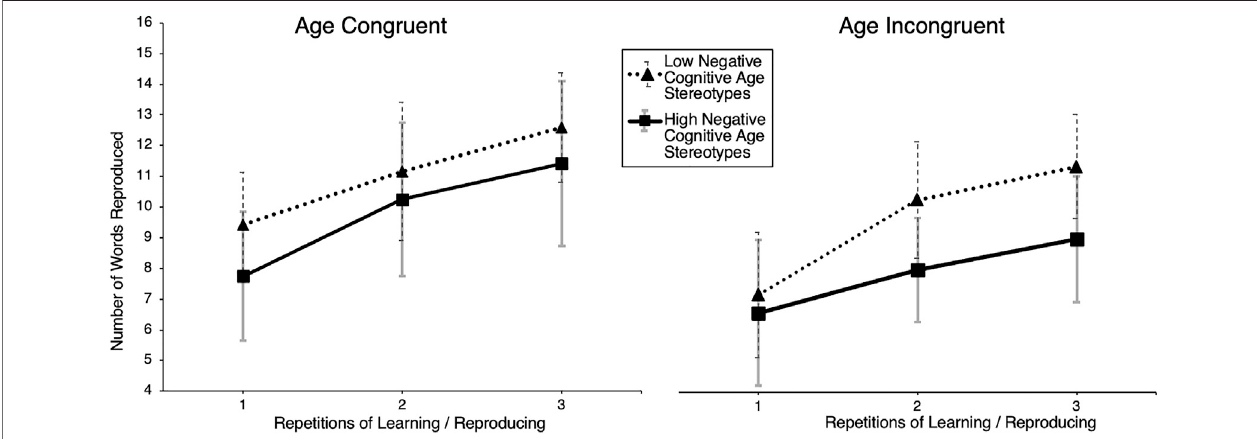
FIGURE 7 | Memory performance by experimental condition and cognitive age group stereotype negativity. Note. Number of words reproduced from the verbal encoding and recall task of young participants, displayed separately for the YA y (young avatar) and OA y (old avatar) subgroups over three repeated measures with separate graphs for (median split) low and high negative domain-matched (cognitive)